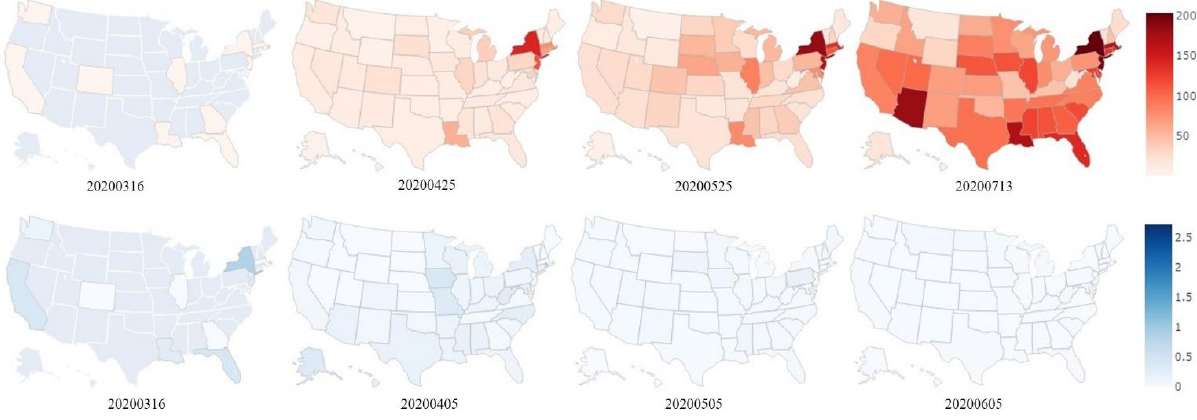
Figure A3. Confirmed COVID-19 cases per 10,000 people (top) and growth rate (bottom) across the US.